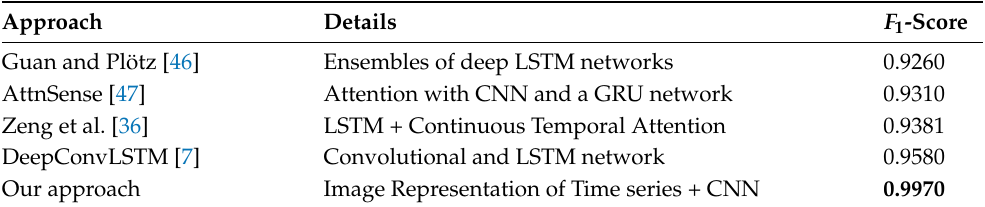
Table 8. Comparison considering Skoda Mini checkpoint dataset.